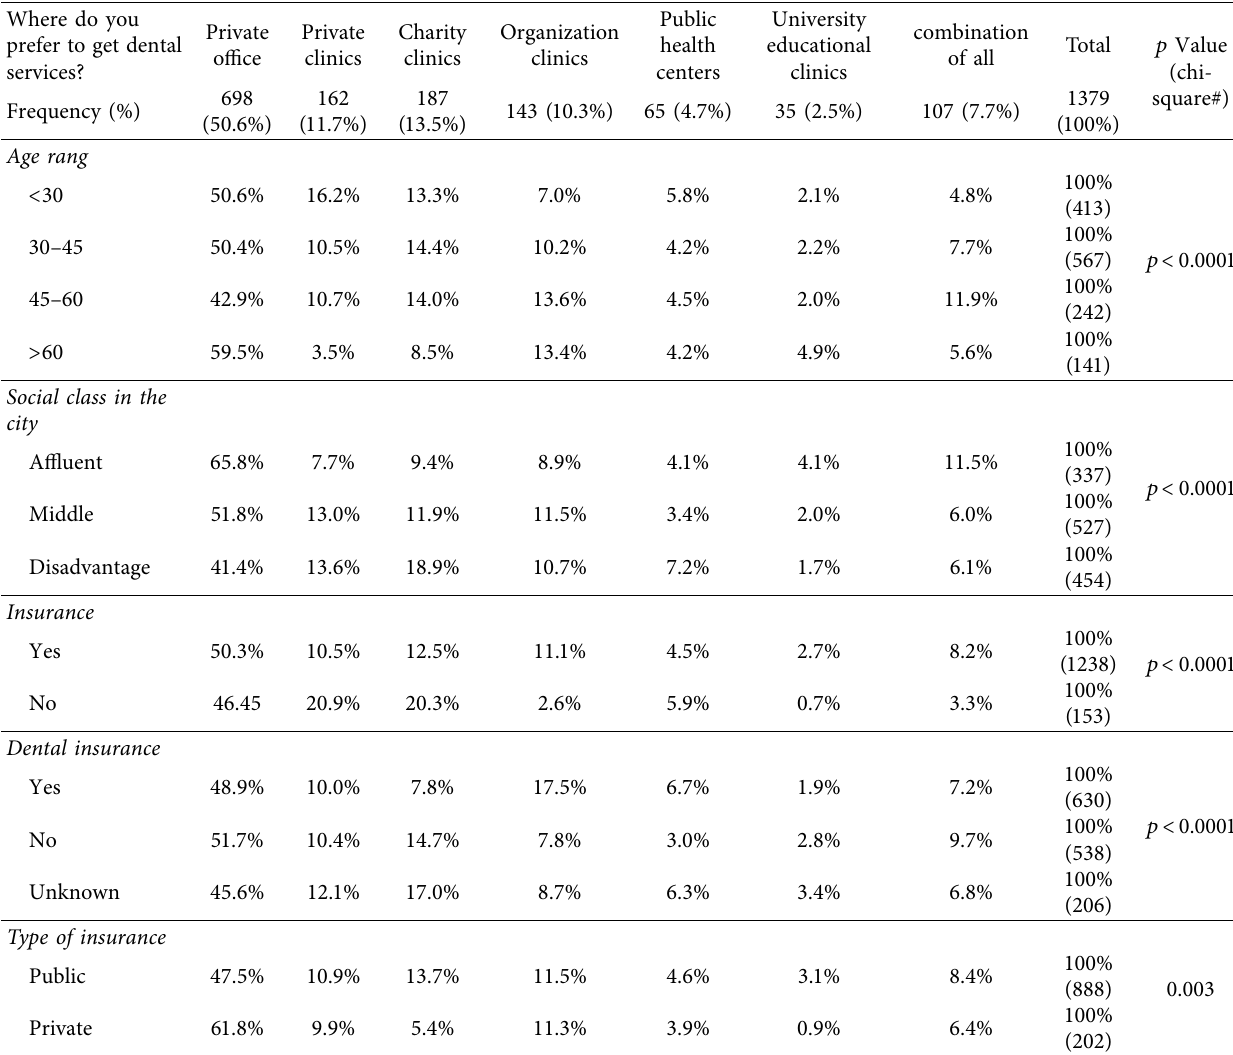
Table 2: Participant’s preferences for dental settings according to their demographic and socioeconomic characteristics. Where do you prefer to get